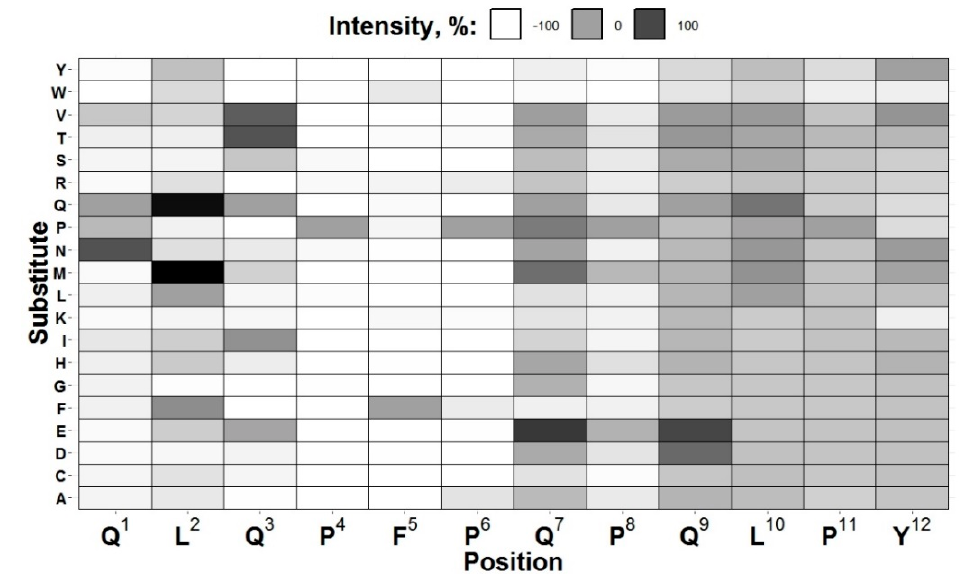
Figure 1. X6 antibody reactivity with the studied peptide set heat map. The color intensity is